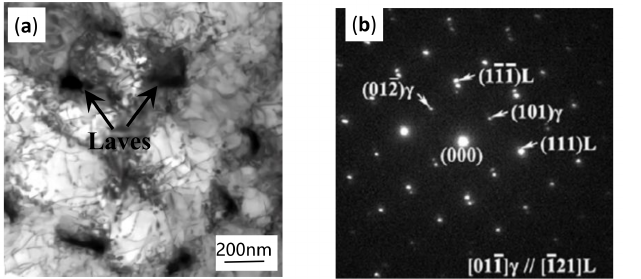
Figure 6. ( a ) TEM image displaying the irregular precipitates in the X-Y plane and ( b ) SAED patterns of Laves and γ